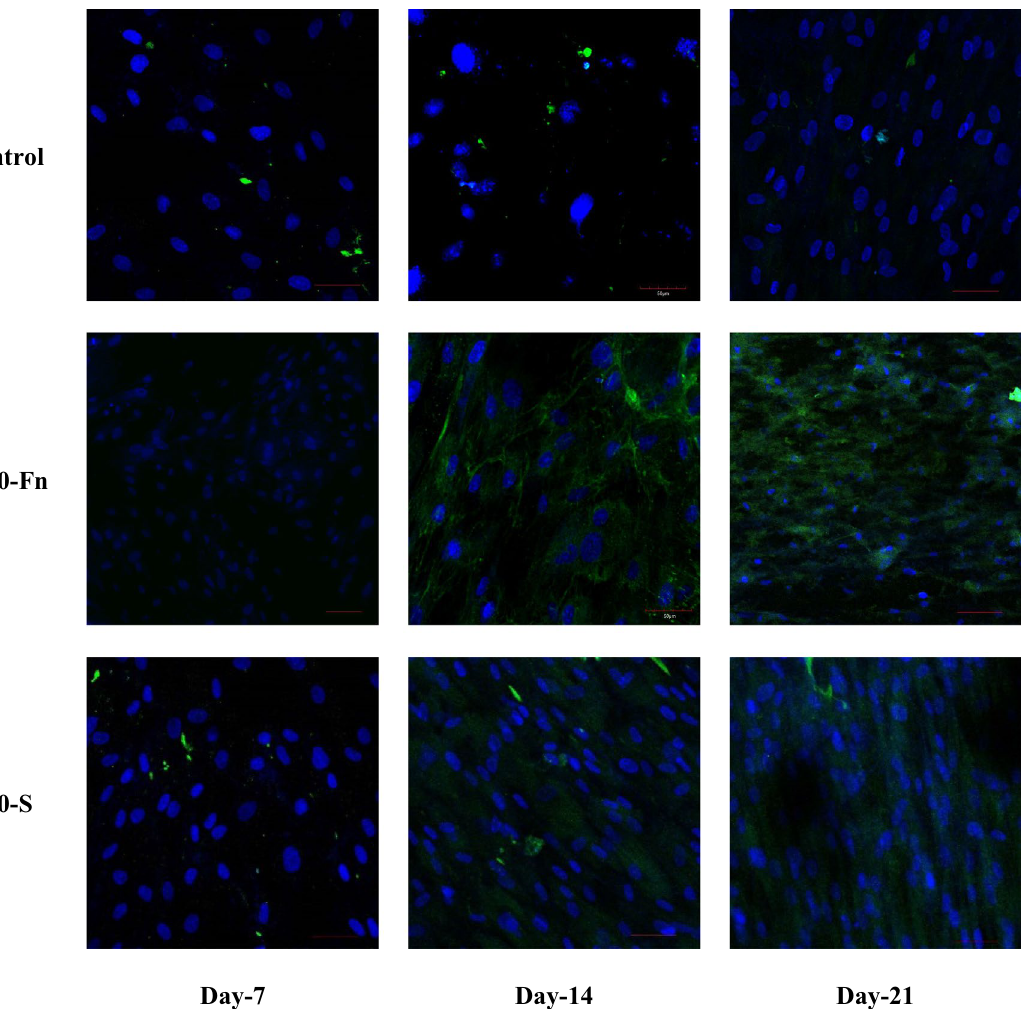
Figure 12. Immunocytochemistry (ICC) of Collagen type II from hWJ-MSCs grown on spidroin and fibronectin micropattern after 7, 14, and 21 days of culture (Control = non-coated coverslip, 1000-Fn = 1000